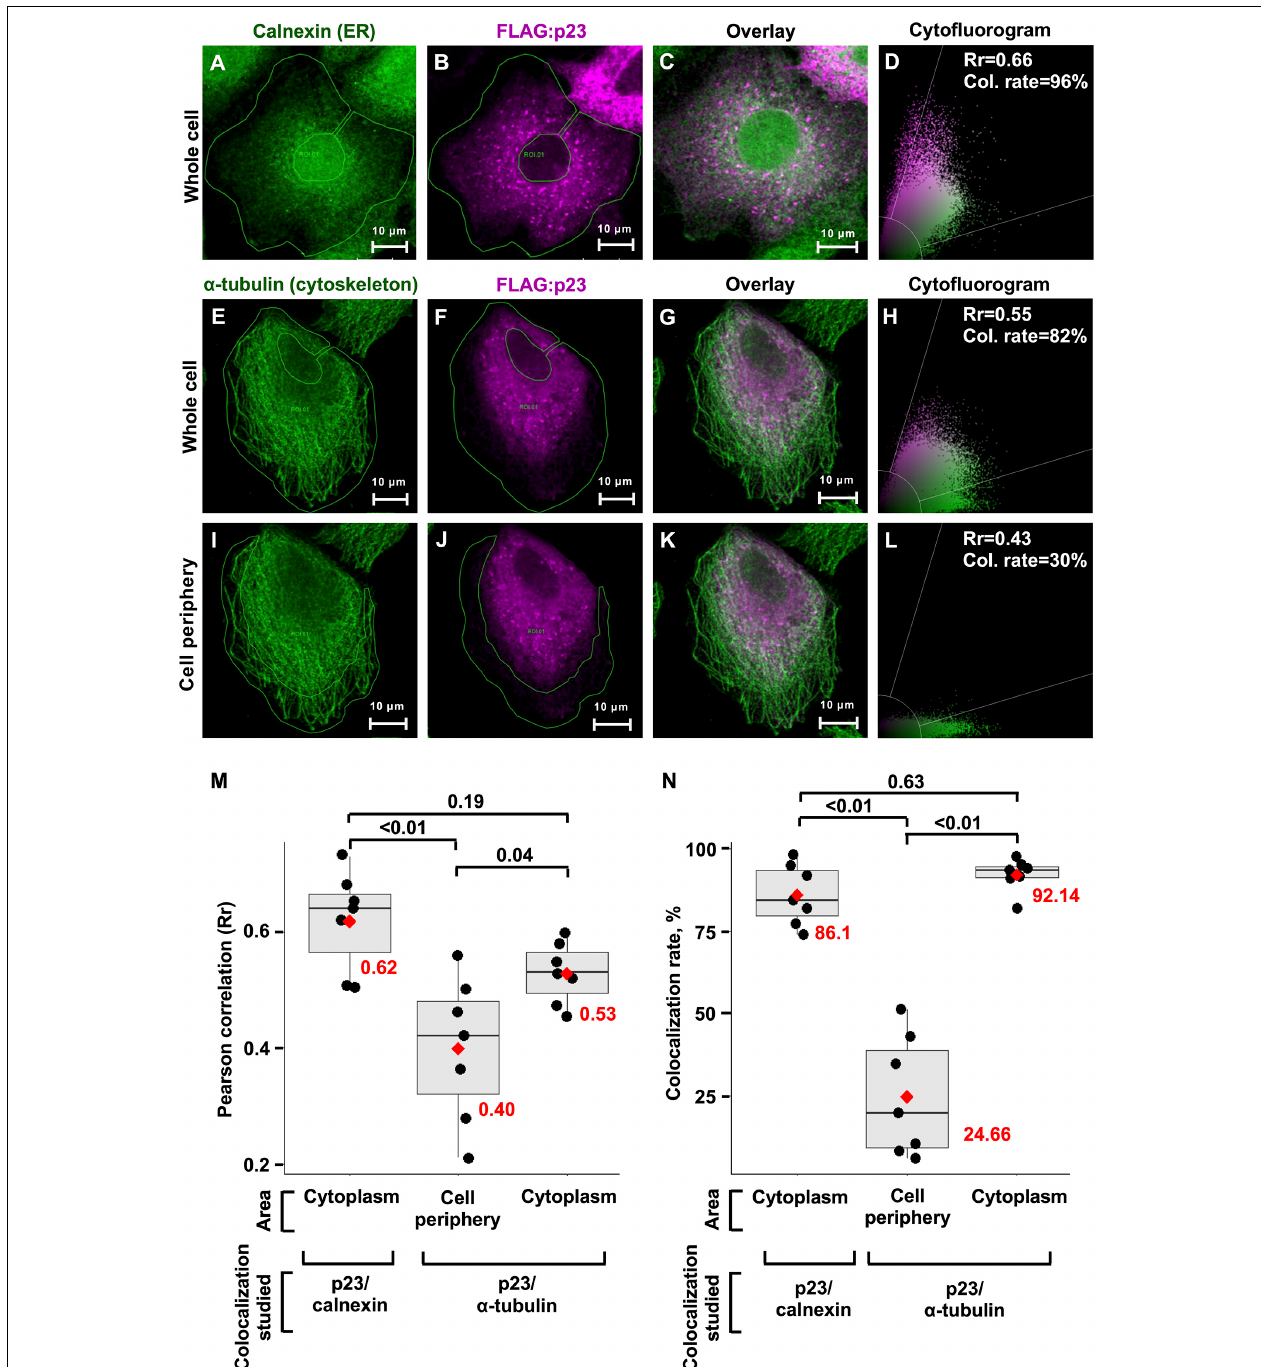
FIGURE 4 | Transiently expressed recombinant p23 localizes to the ER. RK-13 cells were transfected with FLAG-tagged p23 (RHDV), incubated overnight, fixed, immunostained, and analyzed by confocal microscopy. (A–C) The ER marker calnexin (green) and FLAG-tagged p23 (magenta) were detected by immunofluorescence using anti-calnexin and anti-FLAG antibodies, respectively. (E–H) The cytoskeleton protein α -tubulin (green) and FLAG-tagged p23 (magenta) were detected by immunofluorescence using anti-tubulin and anti-FLAG antibodies, respectively. (I–L) The cell periphery lacks p23 expression and therefore this area was used to estimate the threshold for Rr. (D,H,L) The cytofluorograms show the distribution of green and magenta pixels in the cytoplasm (areas under investigation are bounded by a green line); Rr, Pearson correlation coefficient and Col. rate (%), colocalization rate. (M,N) Boxplots represent the distribution of Rr and colocalization rates for seven individual cells ( n = 7), respectively. Each cell is depicted as a black dot, the median for each group is shown as a black line inside the boxes, the position of the mean is shown as a red diamond, and the value of mean is given in red numbers. Significance was analyzed using one-way ANOVA followed by Tukey’s honest significant difference test; adjusted p -values are shown above the plots; plots were produced using ggplot2 (Gómez-Rubio, 2017).